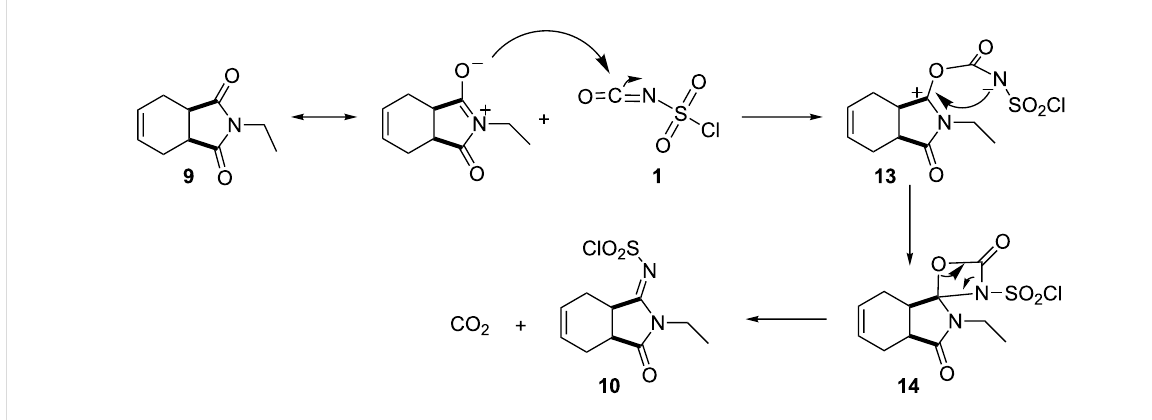
Scheme 4: Mechanism for the formation of ylidenesulfamoyl chloride 10 .